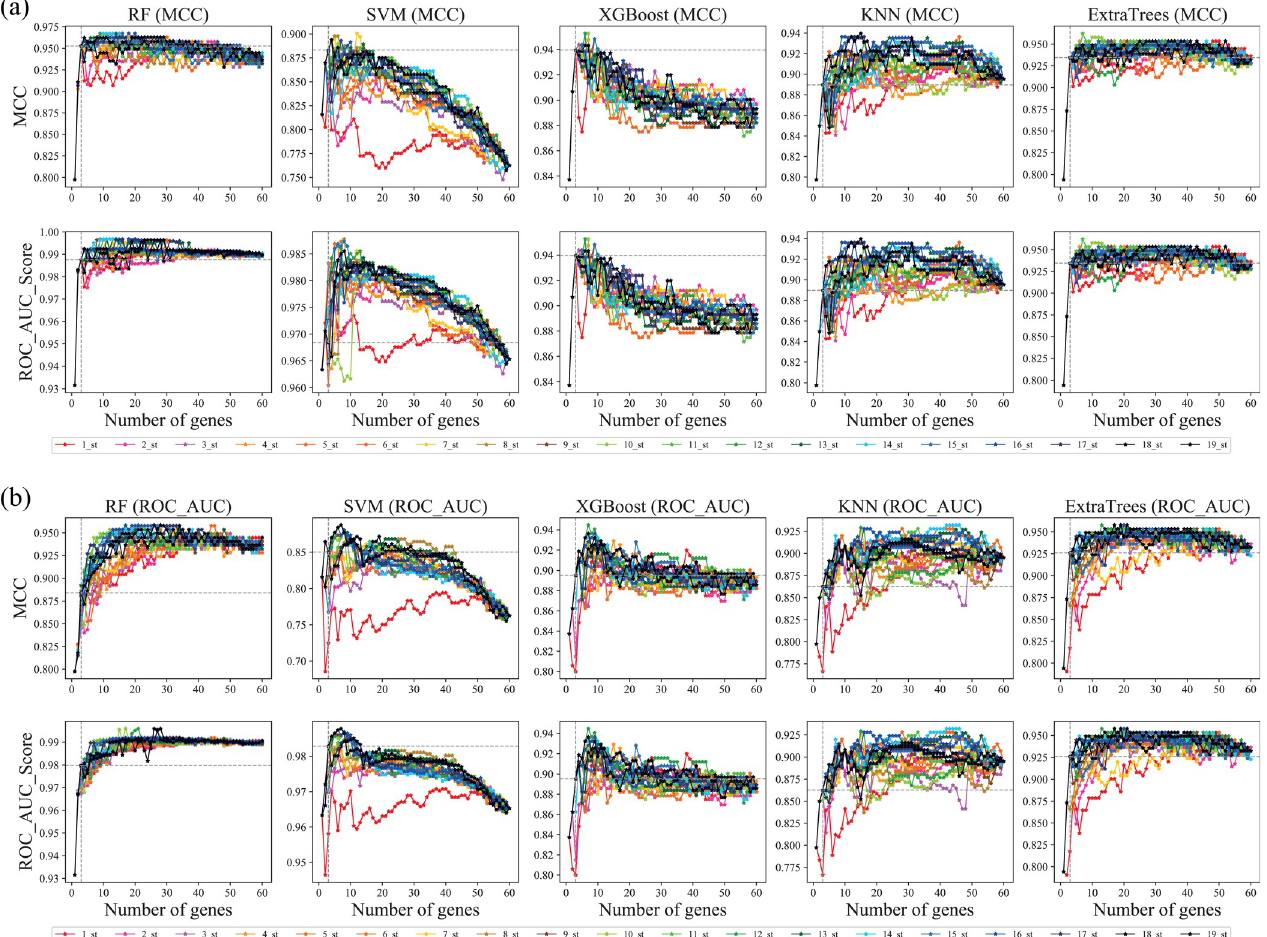
Fig 6. Polylines of classification metrics, MCC, and ROC_AUC_score in 19 iterations. (a) MCC as the object of difference analysis. (b) ROC_AUC_score as the object of difference analysis.